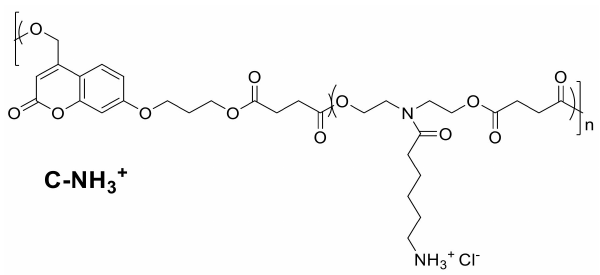
Figure 23. Structure of the cationic coumarin